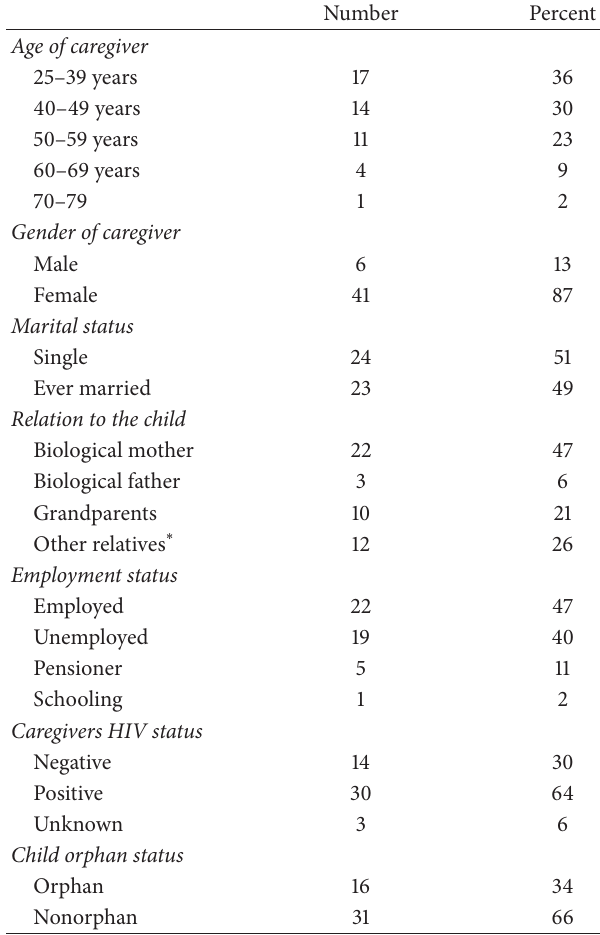
Table 1: Demographic characteristics of caregivers perinatal infected